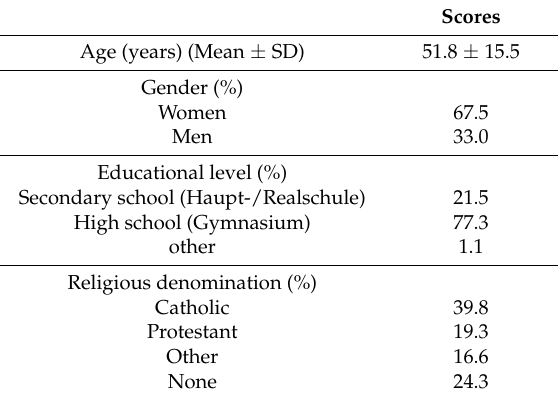
Table 1. Description of the sample ( N = 183).